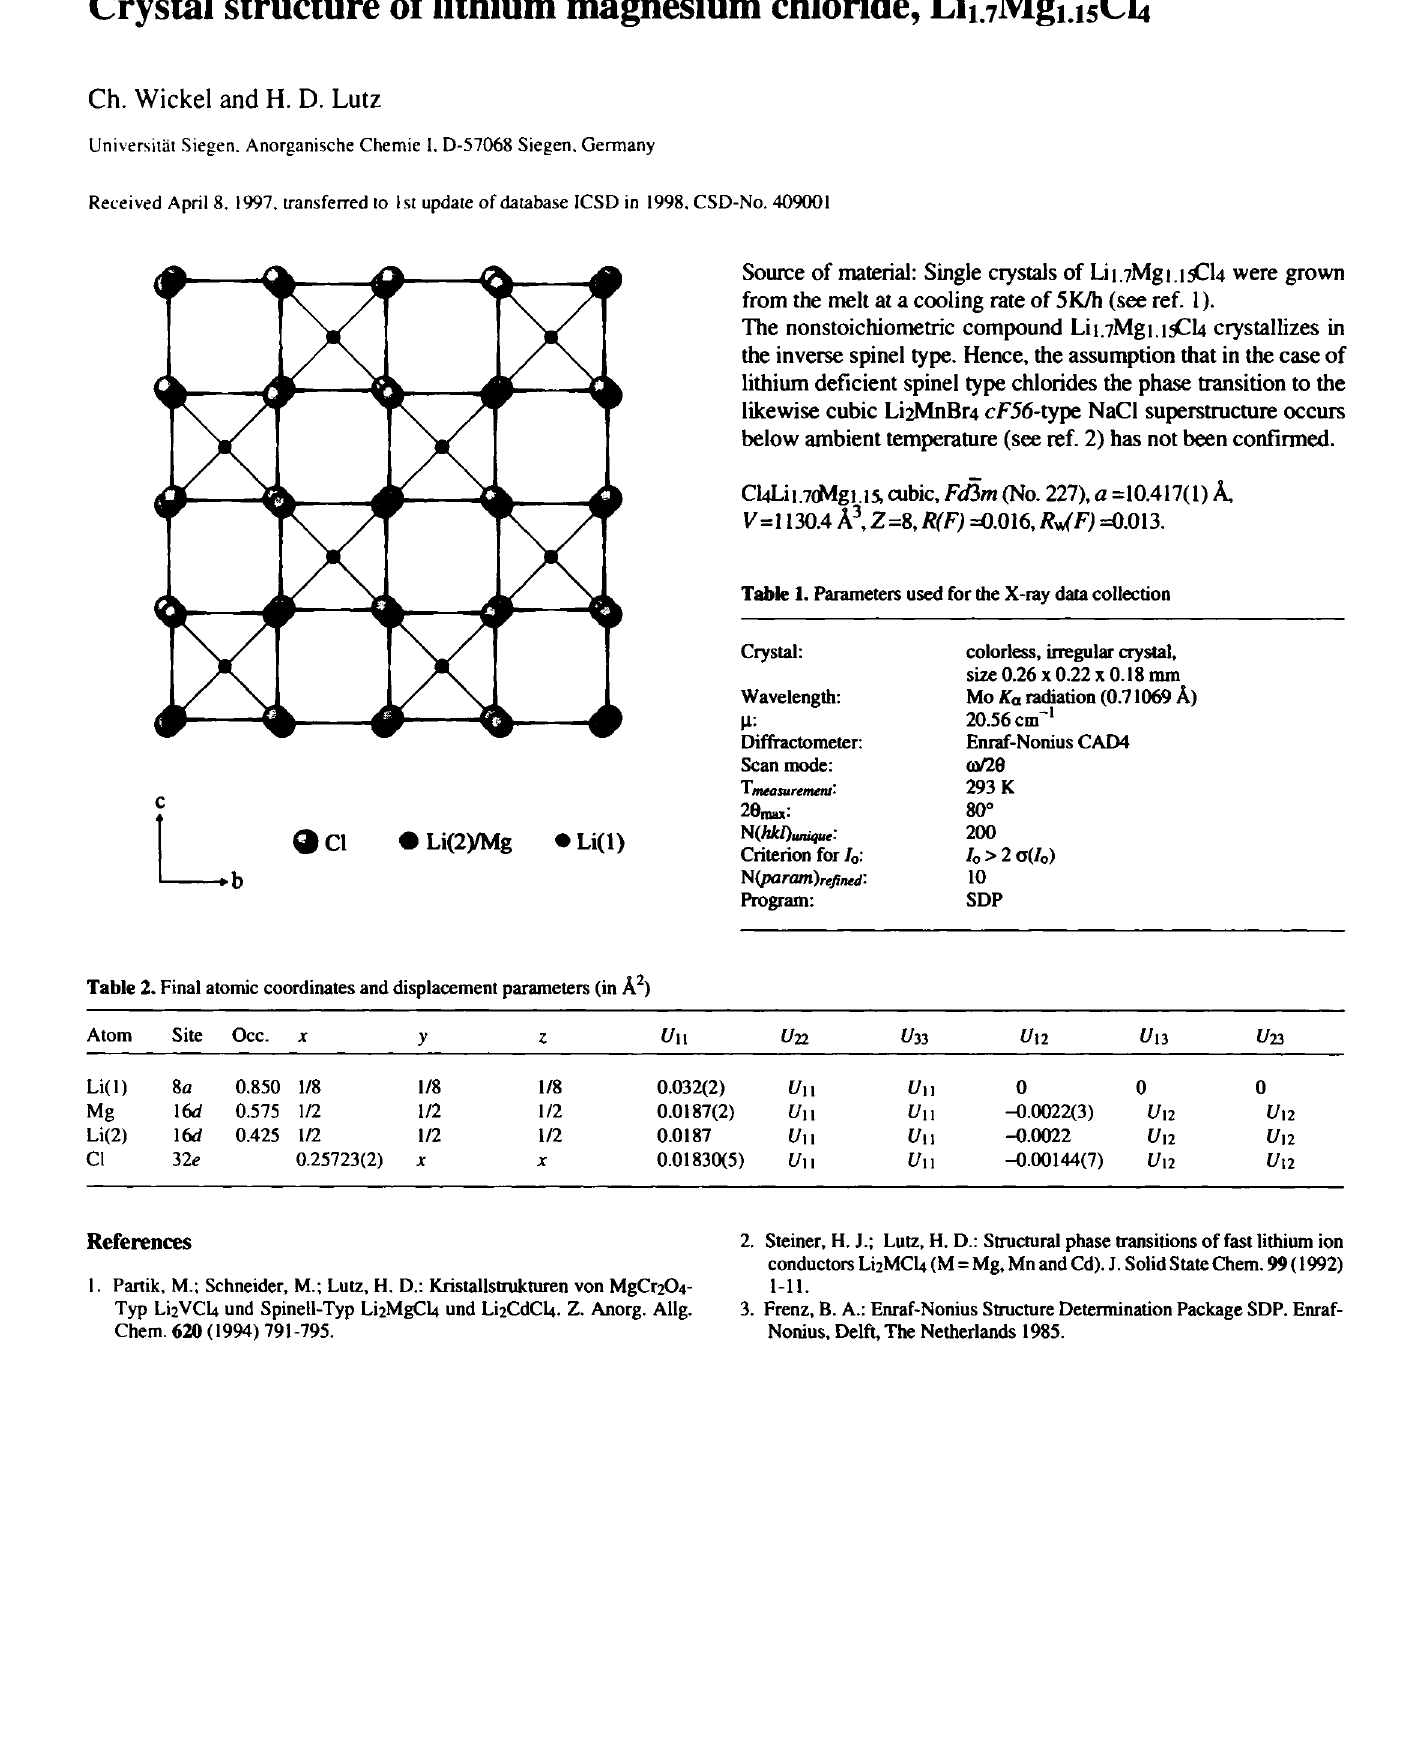
Source of material: Single crystals of Lii .7Mgi .i5Cl4 were grown from the melt at a cooling rate of 5 ΚΛ (see ref. 1 ). The nonstoichiometric compound Lii.7Mgi.isCl4 crystallizes in the inverse spinel type. Hence, the assumption that in the case of lithium deficient spinel type chlorides the phase transition to the likewise cubic LÌ2MnBr4 cF56-type NaCl superstructure occurs below ambient temperature (see ref. 2) has not been confirmed.